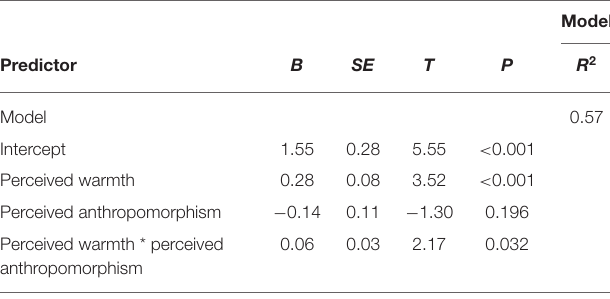
TABLE 10 | Moderated regression analysis testing the effect of perceived warmth on attributed trustworthiness moderated by perceived anthropomorphism within study